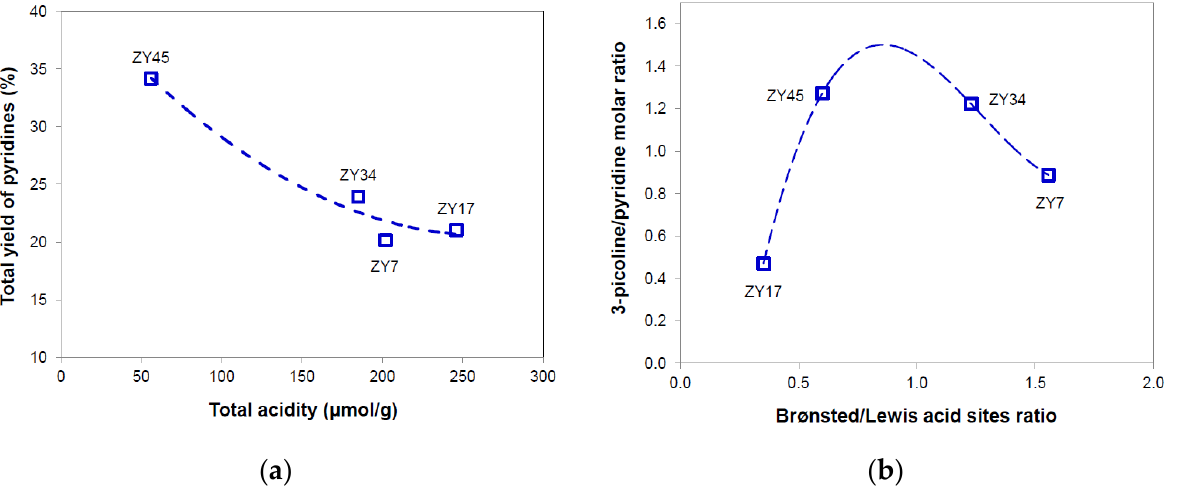
Figure 8. ( a ) Effect of the catalyst total acidity on the total yield of pyridines and ( b ) effect of the Brønsted/Lewis acid sites ratio on the 3-picoline/pyridine molar ratio. Furthermore, the type and amount of acid sites influenced the selectivity of pyridine products. As shown in Figure 8b, the Brønsted/Lewis acid sites ratio deviated from unity to lower or higher values, 3-picoline was the main pyridine product. However, the 3- P/Py molar ratio approaches 1 (this is similar amounts of 3-picoline and pyridine) in the BAS/LAS range between 0.6 and 1.3, as with catalysts ZY34 and ZY45. The further increase or decrease of the BAS/LAS ratio originated smaller values of the 3-P/Py molar ratio than unity, and the reaction proceeded preferentially towards pyridine. Remarkably, the formation of pyridine occurred more selectively over LAS than BAS; i.e., the ZY17 zeolite, the catalyst with the smallest BAS/LAS acid sites ratio, exhibited a smaller 3-P/Py molar ratio than the catalyst with the highest BAS/LAS ratio, namely the ZY7 zeolite. Similar results were reported for the reaction between acrolein and ammonia over an HF/MgZSM- 5 catalyst, where pyridine was found to be produced over strong LAS, and 3-picoline was formed over BAS and weak LAS